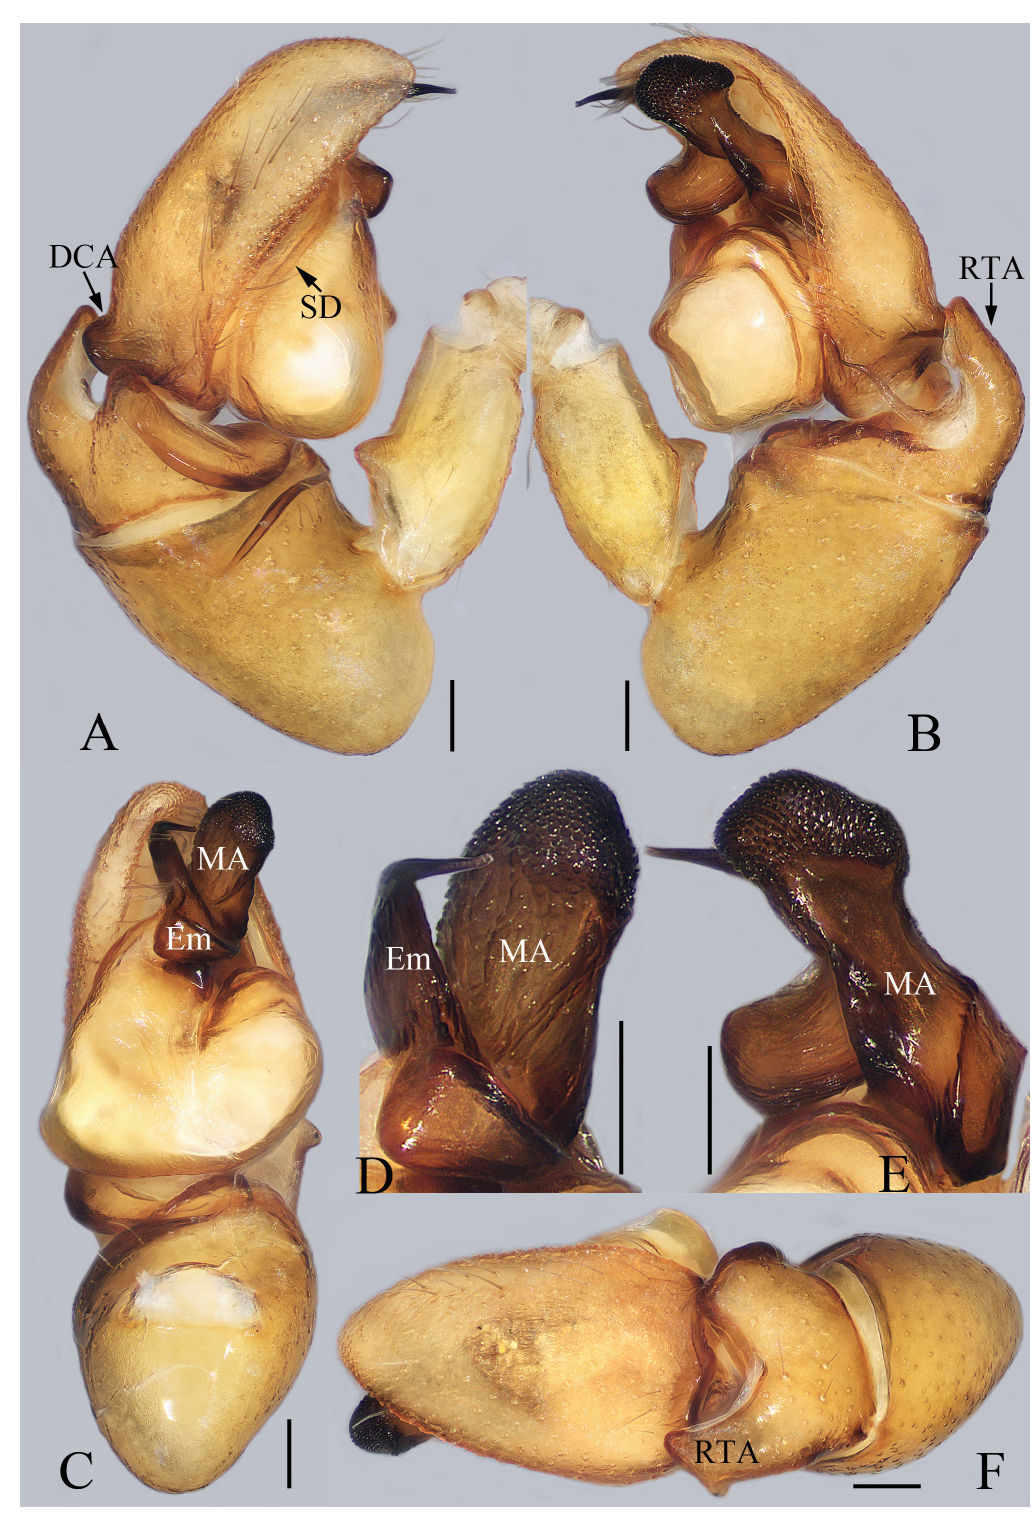
Fig. 5. Male palp of Synagelides leigongensis sp. nov. A – C , F . Holotype, ♂ (TRU-Salticid-0012). D – E . Paratype, (TRU-Salticid-0013). A . Prolateral view. B . Retrolateral view. C . Ventral view. D . Embolus and median apophysis, ventral view. E . Embolus and median apophysis, retrolateral view. F . Dorsal view. Abbreviations: see Material and methods. Scale bars = 0.1